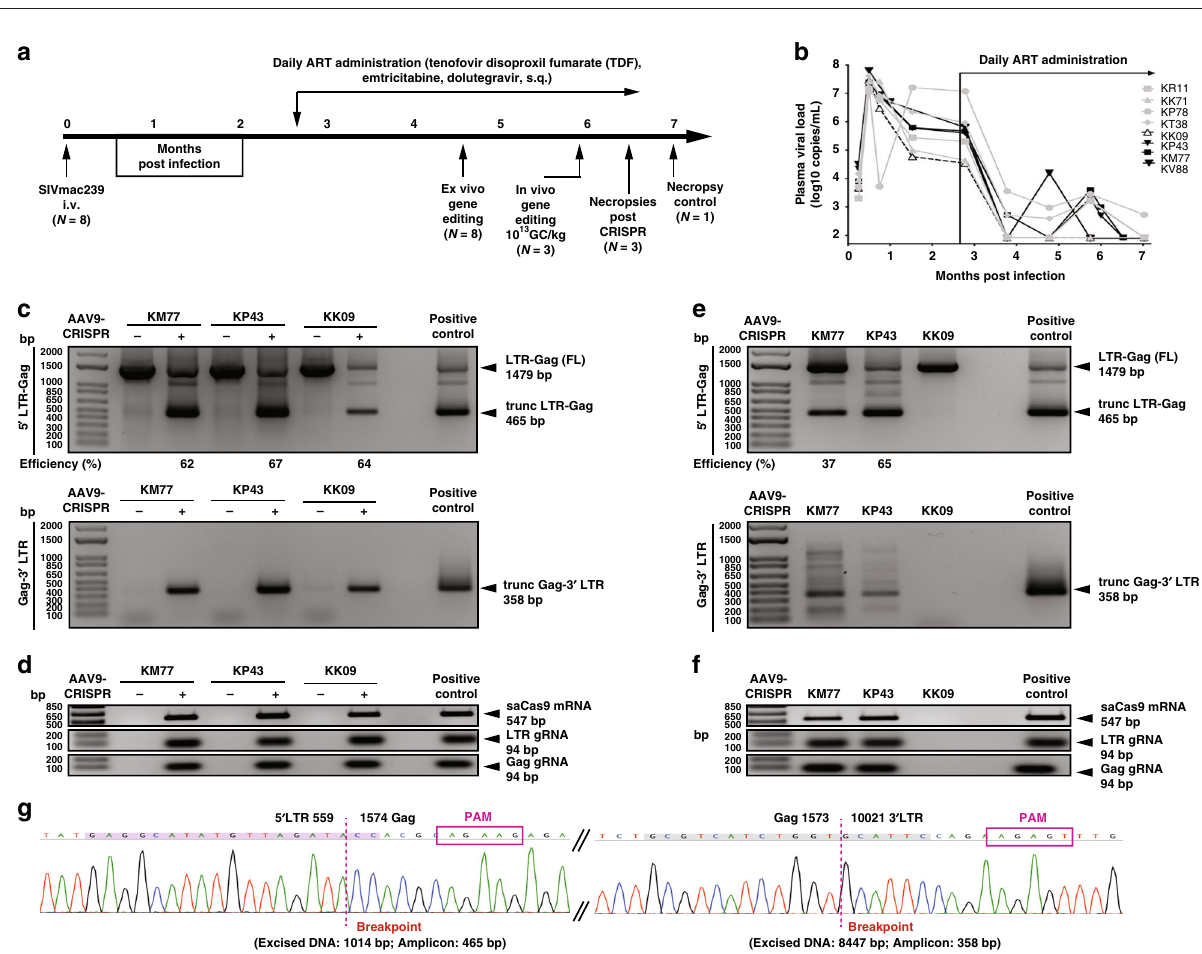
Fig. 1 Construction, map and con fi rmation of the CRISPR-Cas9 construct targeting SIV proviral DNA in vitro. a Schematic presentation of the full-length SIVmac239 genome (GenBank: M33262.1) with positions of targeted sites, predicted cleavage events and gRNAs sequences. b Map of AAV pX601- SaCas9-2xgRNA plasmid. c Con fi rmation of the expression of the plasmid SaCas9 and gRNAs. RT-PCR analysis of SaCas9 and gRNA expression in HEK293T cells transfected with the plasmid. d Gel electrophoresis analysis of PCR reaction for detection of SIV DNA after the treatment of cells with AAV9 delivering CRISPR-Cas9. Results from the PCR analysis showed a clear band of 465 bp in size in the cells that received the CRISPR-Cas9 by infection with AAV9 expressing CRISPR-Cas9. The percent excision ef fi ciency (Ef fi ciency (%)) in vitro shown under the PCR was calculated by quanti fi cation of the excised band (trunc.) divided by the sum of the full-length (FL) plus the excised bands times 100%. e Results from the PCR analysis showed a clear band of 358 bp in size in the cells that received the CRISPR-Cas9 by infection with AAV9 expressing CRISPR-Cas9. f Results from the sequencing of the 465 bp amplicon showed the breakpoint of the viral DNA, where the truncated 5 ′ LTR is joined to the residual Gag gene after the removal of the 1014 bp DNA. g Results from the sequencing of the 358 bp amplicon showed the breakpoint of the viral DNA, where the truncated gag is joined to the residual 3 ′ LTR after the removal of the 8447bp DNA. Full sequencing data are available in the source fi le data provided with this paper. Source data are provided as a Source Data fi le.